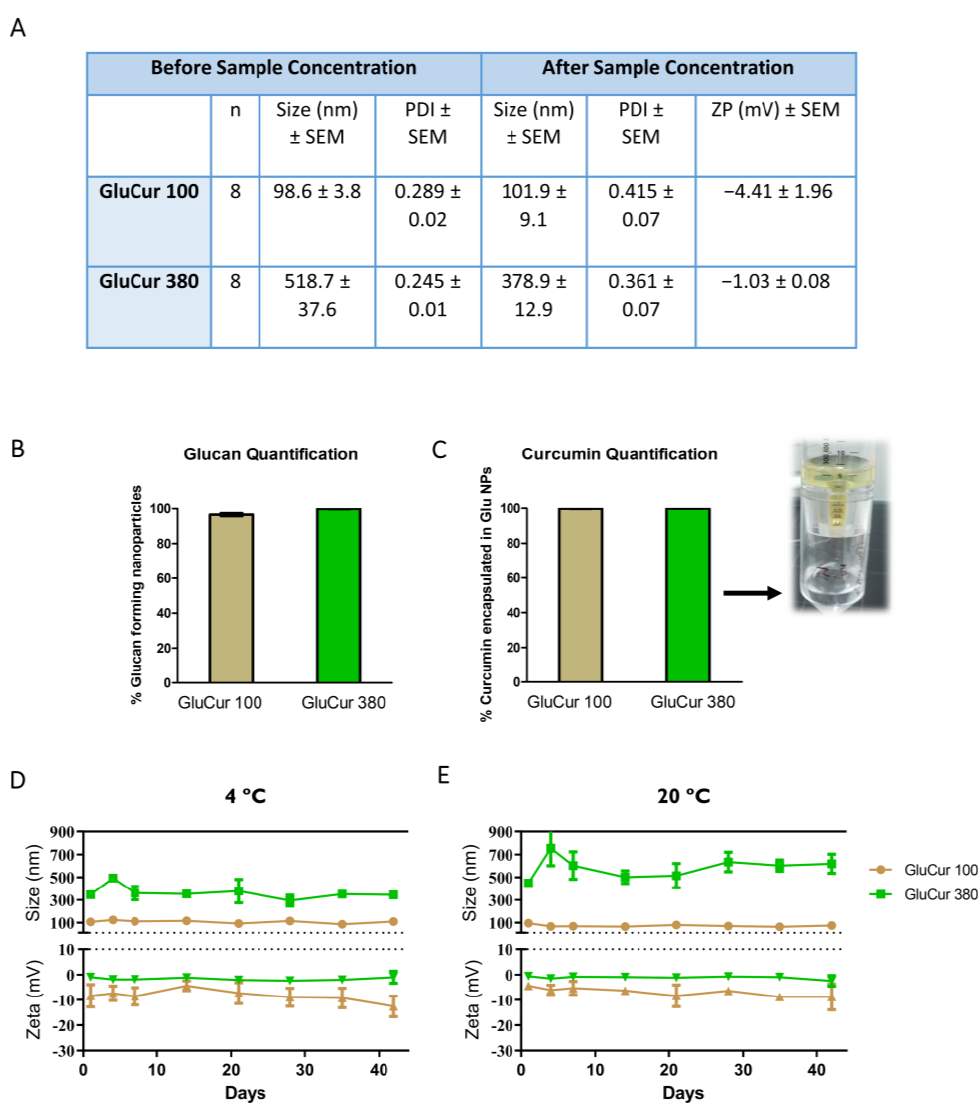
Figure 1. Physicochemical characterization of curcumin-loaded glucan NPs. ( A ) the mean size distribution, polydispersity index, and zeta potential were measured before (in the initial medium) and after concentration (in pyrogen-free water) of the particles. Data are presented as the mean ± SEM, n = 8 (eight independent experiments, each in triplicate). ( B ) Estimation of 1,3- β -glucan content that was used to produce curcumin nanocarriers through the aniline blue fluorescence microassay. ( C ) Quantification of curcumin using a calibration curve of known concentrations of the drug in the solvent of NPs via a UV–Visible spectrophotometer. Illustrative image of the filtrate obtained from the centrifugation of NPs with curcumin encapsulated using Vivaspin (lower part of the centrifugal tube). Assessment of the temperature effect at 4 ◦ C ( D ) and 20 ◦ C ( E ) on the stability of GluCur 100 and GluCur 380 NPs by measuring the size and zeta potential over 42 days. Data are presented as the mean ± SEM, n = 3 (three independent experiments, each in triplicate).